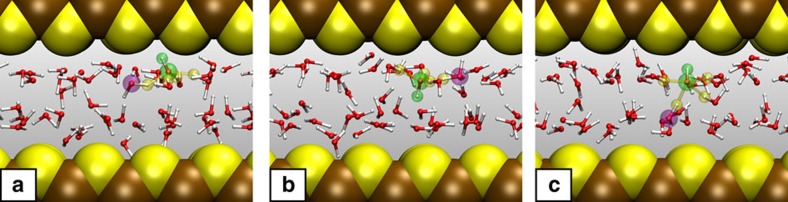
Snapshots depicting different representative configurations of OH−(aq) in the wide slit pore.System W, where a covers the ‘exposed' state E, as well as the ‘buried' and ‘tilted' states B/T in b and c, respectively; see Fig. 5 for definitions.